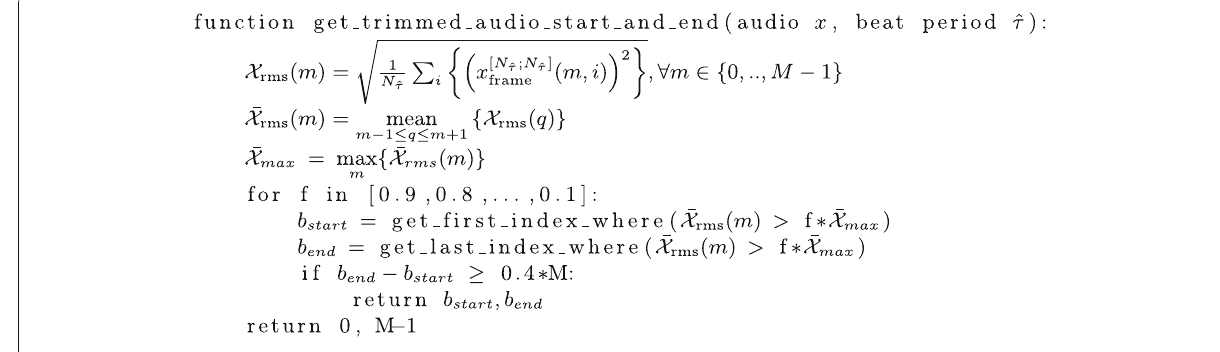
Fig. 5 Pseudo-code for the audio trimming algorithm of the downbeat